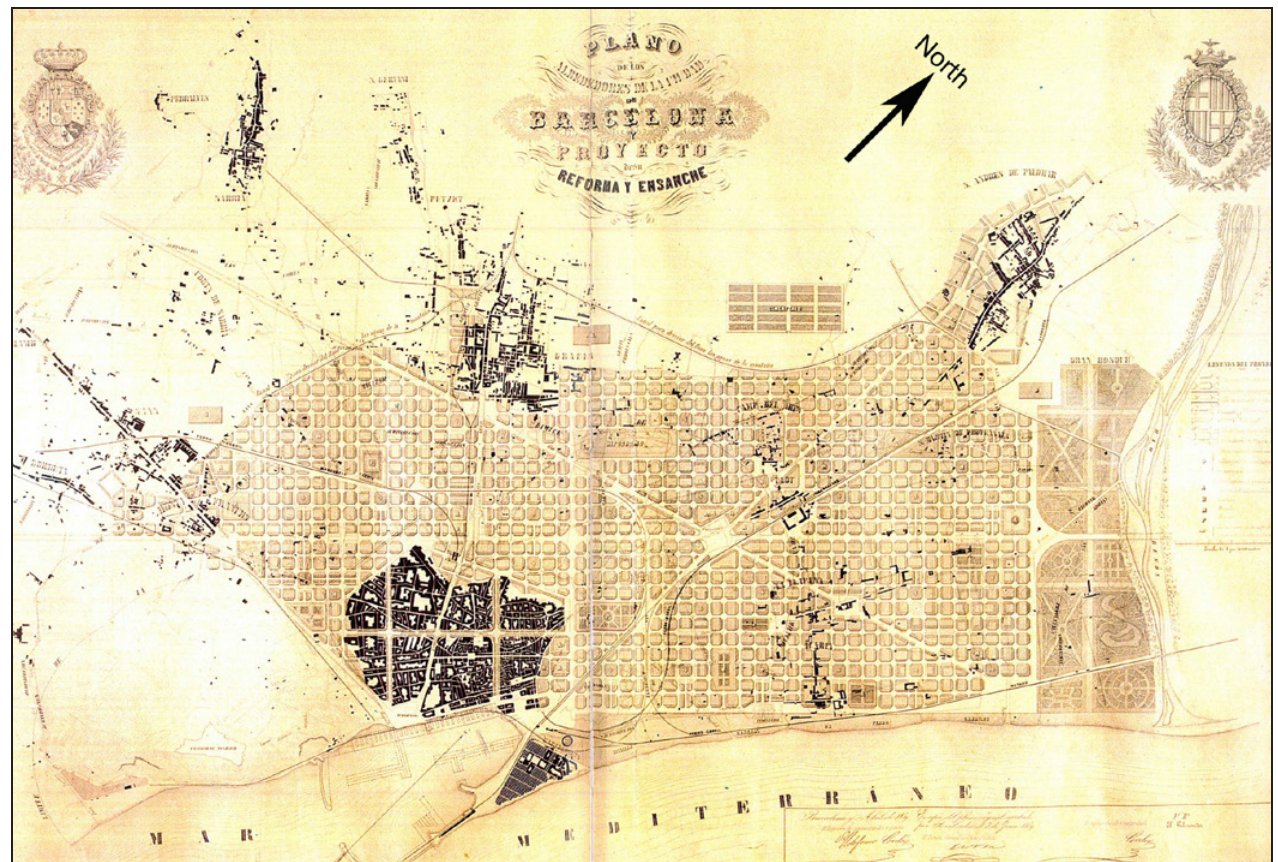
Figure 2: Cerda’s orginal plan for the expansion of Barcelona in 1859. The street blocks were turned at 45° to north, improving solar penetration and shading of the buildings and